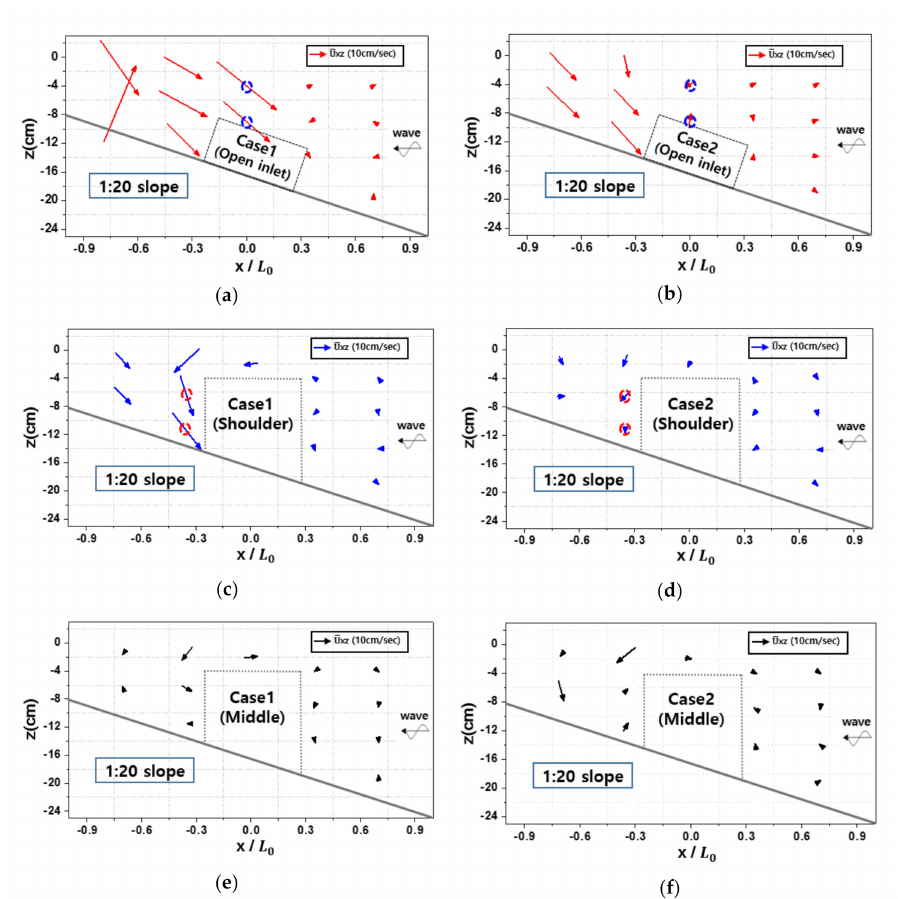
Figure 7. Flow rate vector distribution ( U xz ) in x and z directions by structure type (Case 1: dolos; Case 2: hybrid (dolos with the coral reef)): ( a ) flow rate at the open inlet with only the submerged breakwater (Case 1), ( b ) flow rate at the open inlet with the hybrid method (Case 2), ( c ) flow rate at the shoulder of the structure with only the submerged breakwater (Case 1), ( d ) flow rate at the shoulder of the structure with the hybrid method (Case 2), ( e ) flow rate at the middle of the structure with only the submerged breakwater (Case 1), and ( f ) flow rate at the middle of the structure with the hybrid method (Case 2).